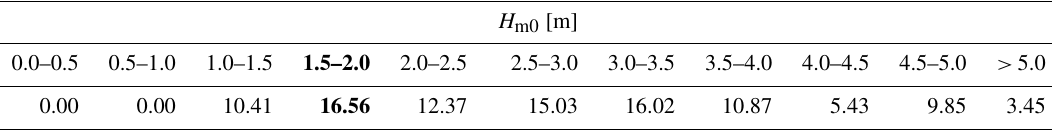
Table 1. Energy-flux distribution (%) in 2012–2013 (only referring to sector 105–135 ◦ ). The most probable class is reported in bold.